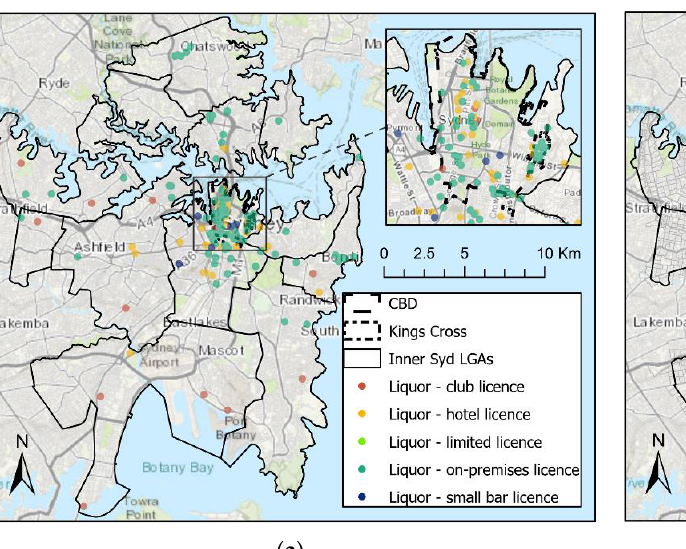
Figure 22. Number of venues by type 2012–2021 in Kings Cross precinct.